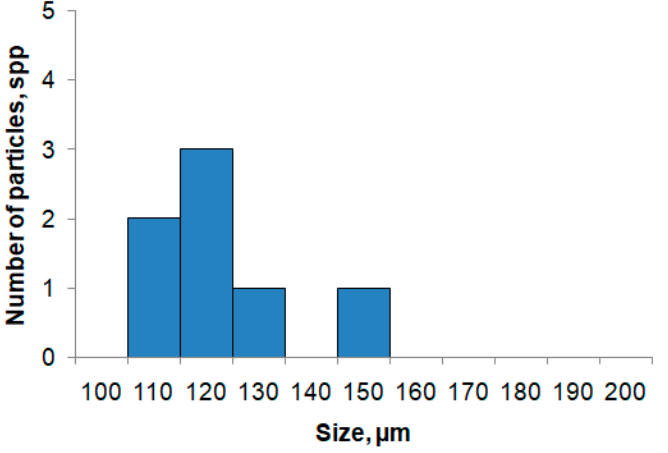
Figure 7. Example of background data represented by depth profiles. Sailing of Ashamba research vessel to the Black Sea on 16 October 2019, station no. 6 with coordinates 44°31.2398 ′ N 37°54.3828 ′ E, submersion up to 500 m: green graph— average turbidity-total fraction of the sectional area volume shielded by particle sections associated with the suspension taxon ( 𝛼 (cid:3020)(cid:3048)(cid:3046)(cid:3043). ); red—water temperature; blue—average biomass of particles. ( a ) In forward motion (submersion); ( b ) In backward motion (lifting), in key areas.